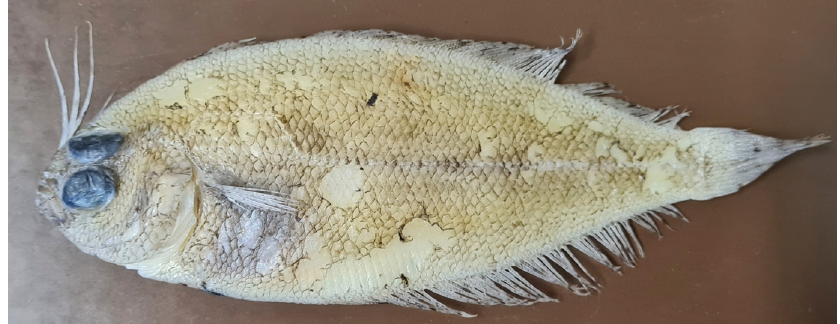
Fig. 6. – Arnoglossus imperialis Rafinesque, 1810, SMNS 27397, male, 118.7 mm SL, neotype of Bothus imperialis Rafinesque, 1810, Bothus punctatus Rafinesque, 1814 and Charybdia rhomdoidichthys Facciolà, 1885, Balearic Islands, northeast of Ibiza. Photograph of preserved specimen. Ocular side.